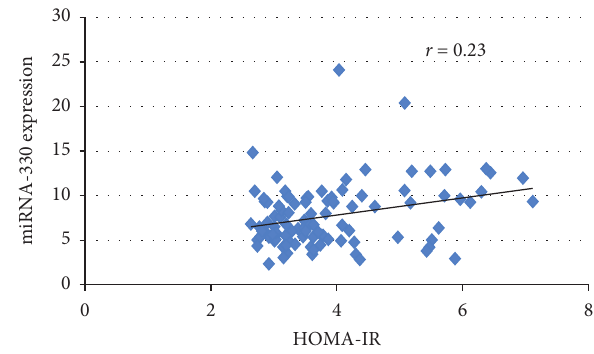
Figure 2: Correlation of HOMA-IR with microRNA-330 ex- pression among T2DM cases.